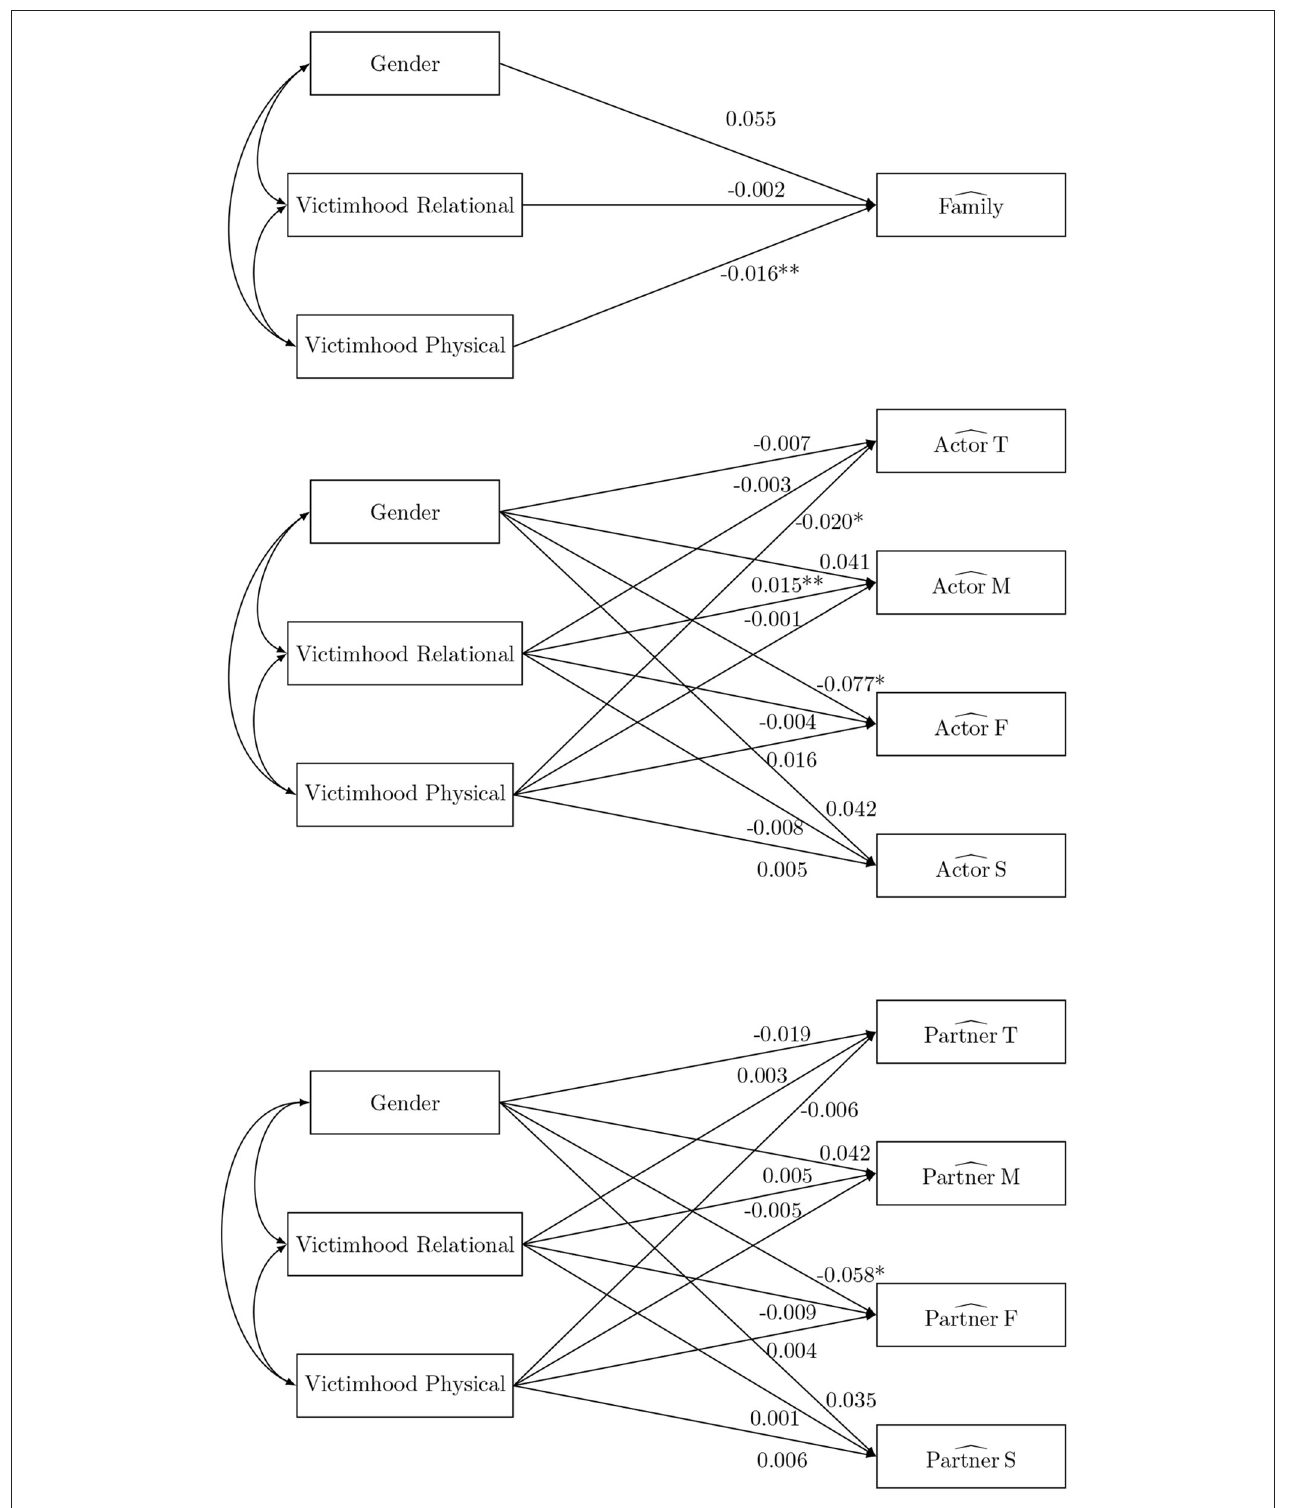
FIGURE 3 | The social relations model components as outcome in the naive ANOVA analysis. * p < 0.05, ** p < 0.01, and *** p < 0.001).